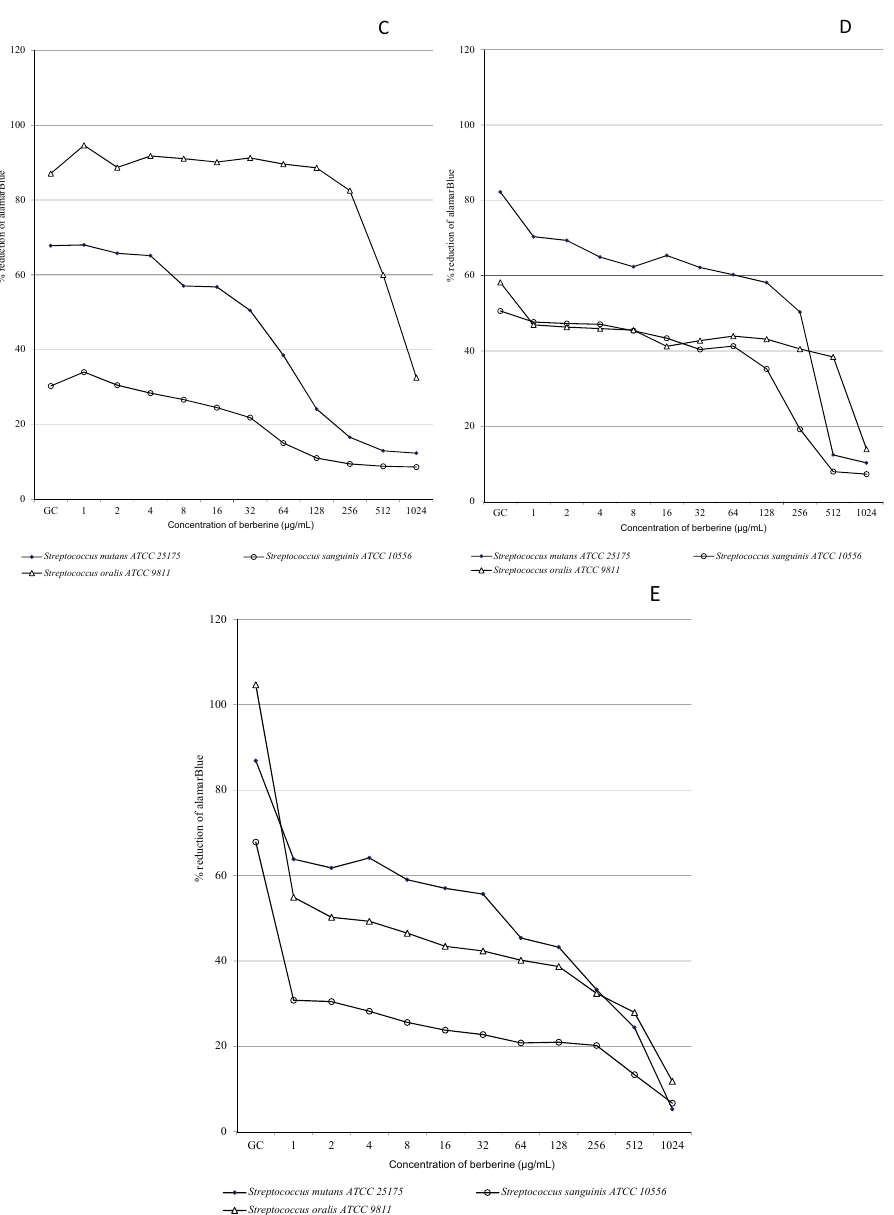
Figure 2. The AlamarBlue reduction ability of oral streptococci exposed to various BECl concentrations. Concentration-response growth curves: ( A ) after 0 h of incubation; ( B ) after 2 h of incubation; ( C ) after 6 h of incubation; ( D ) after 12 h of incubation and ( E ) after 24 h of